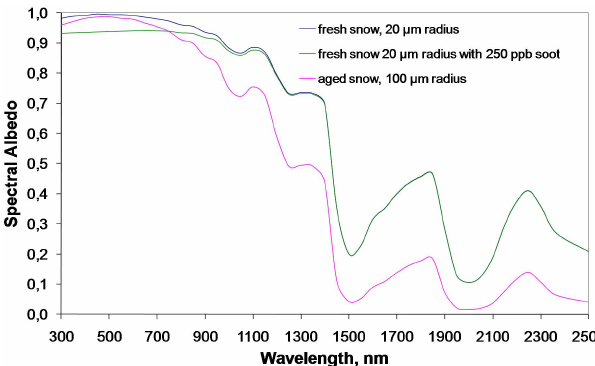
Fig. 1. Spectral albedo of fresh and aged pure snow and of fresh snow contaminated by soot. The plots were calculated using the DISORT radiative transfer code, which simulates snow grains as disconnected spheres of the radius